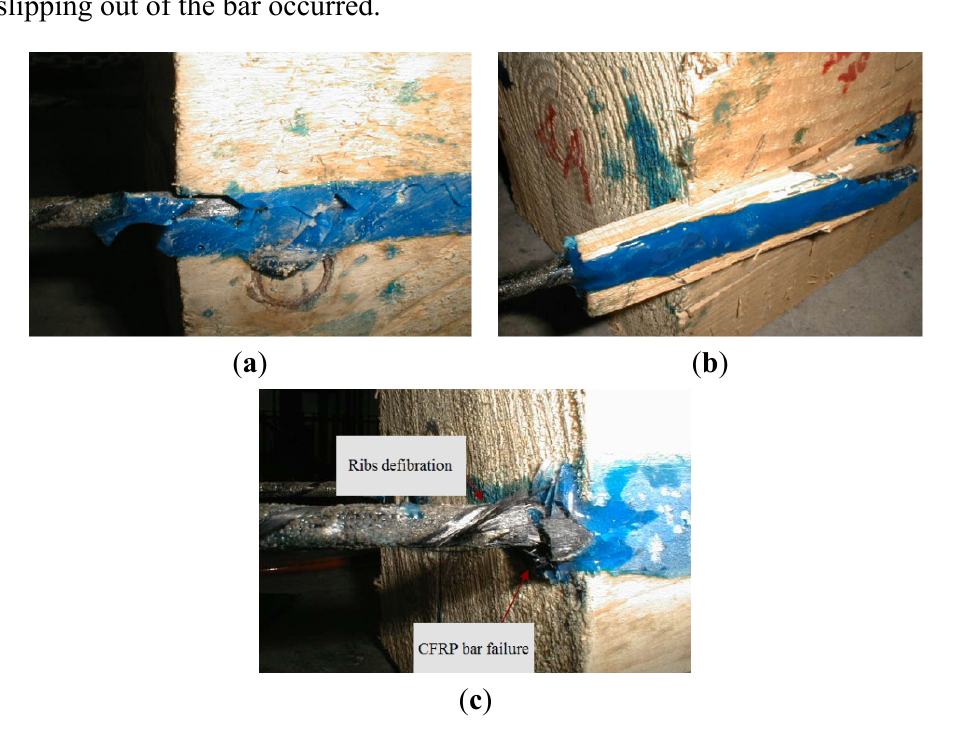
materials surrounding the bar (Figure